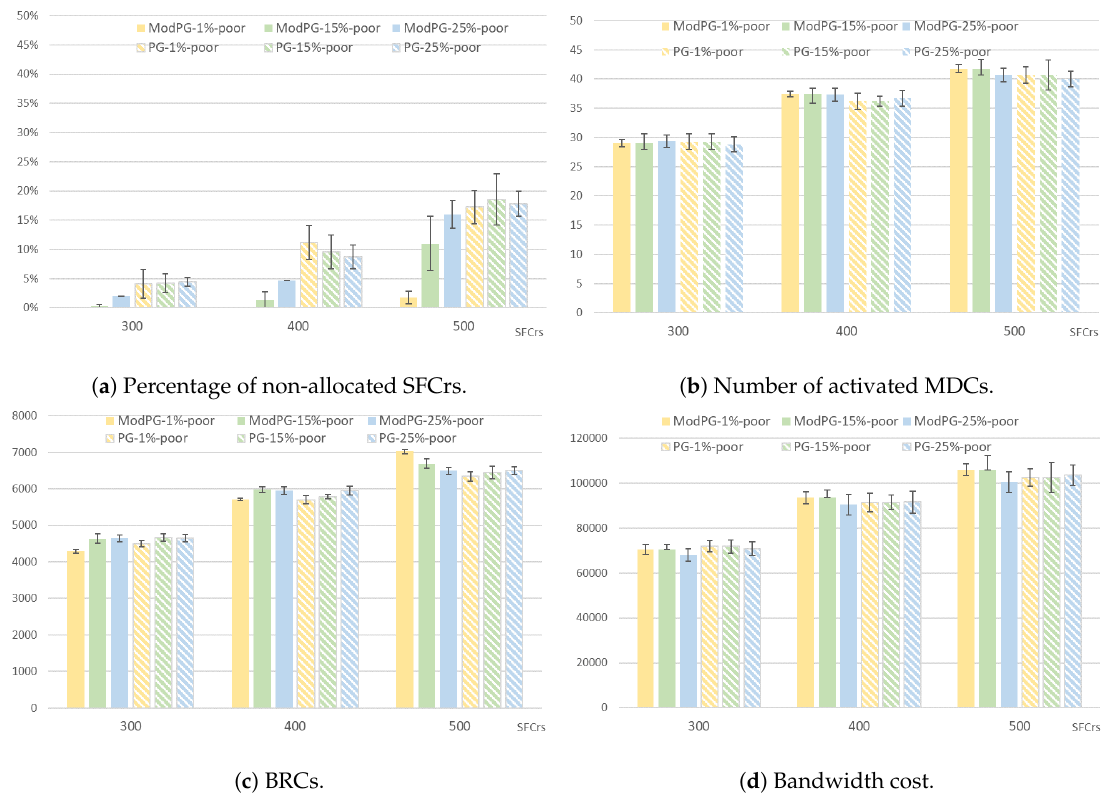
Figure 3. Scenario 1: CPU and memory capacity of MDCs set to 3000.